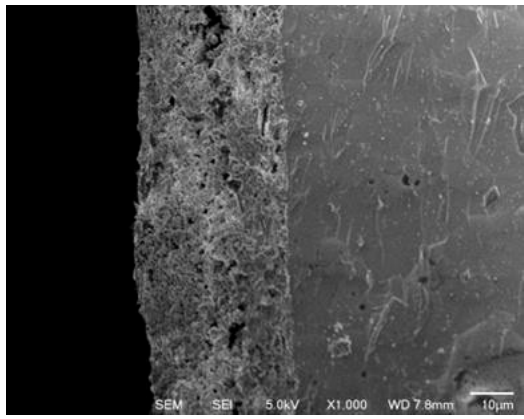
Figure 3. SEM micrograph of the LSCM/GDCW cathode cross section.